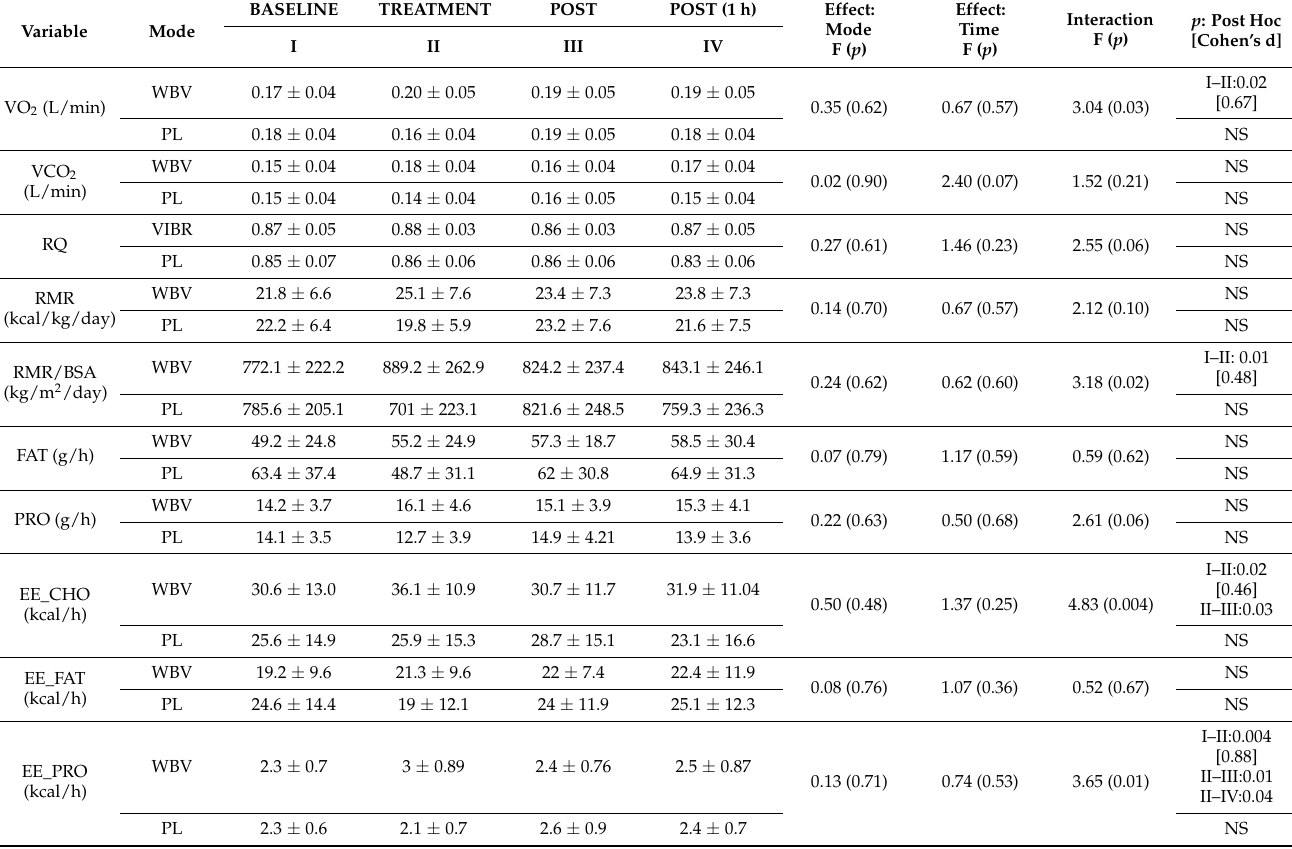
Table 1. Effects of vibration on variables measured during calorimetry.